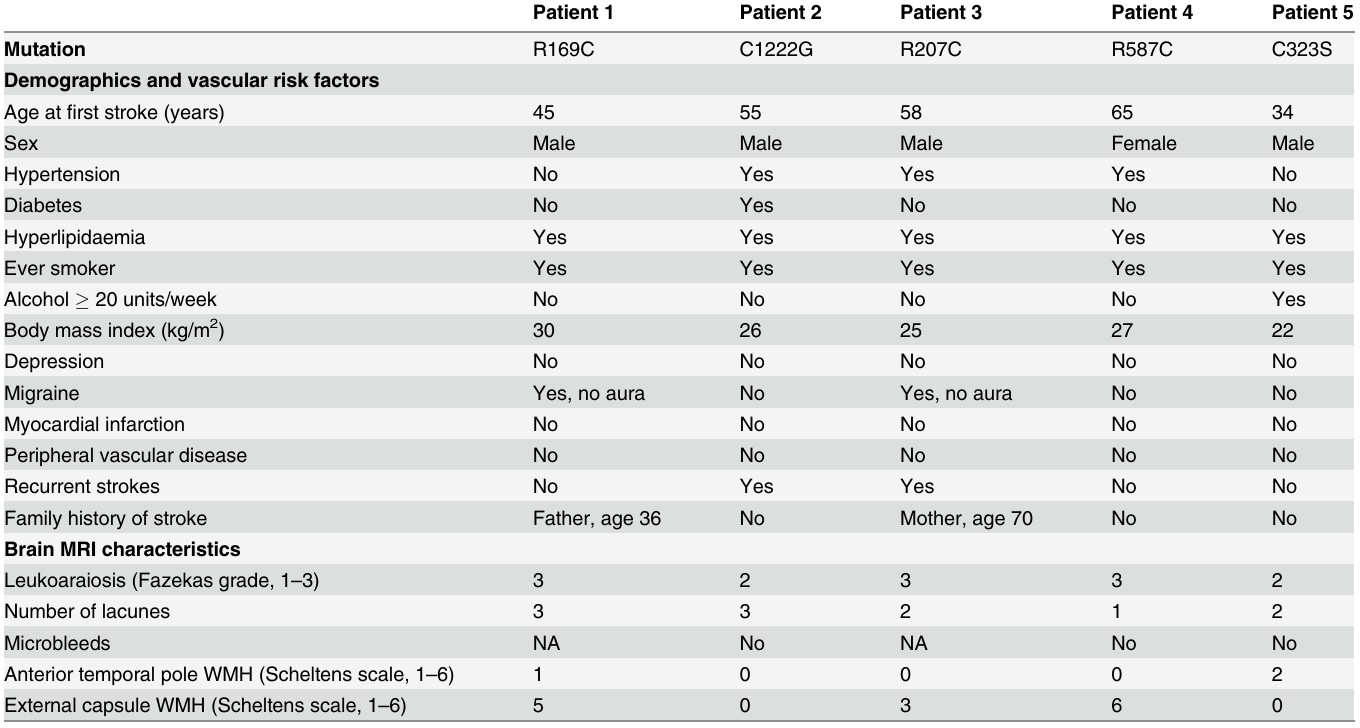
Abbreviations: WMH, white matter hyperintensities; NA, not available.